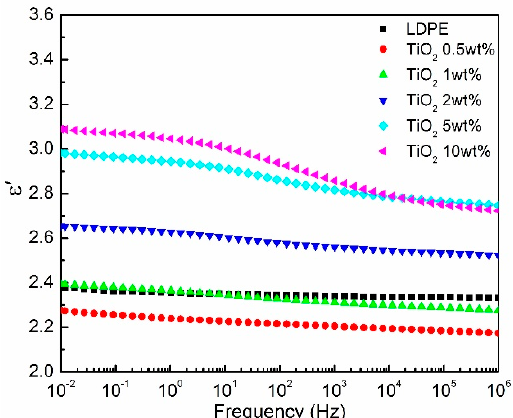
Figure 4. Frequency dependence of real part permittivity of LDPE/TiO 2 nanocomposites.